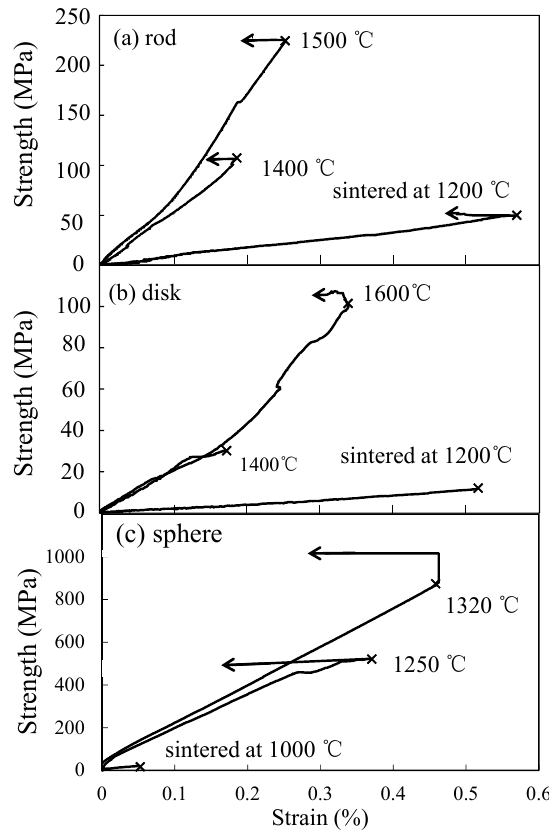
Figure 4. Compressive stress–strain curves for the alumina compacts sintered from ( a ) rod ‐ like particles, ( b ) disk ‐ like particles, and ( c ) spherical particles at 1000–1600 °C.